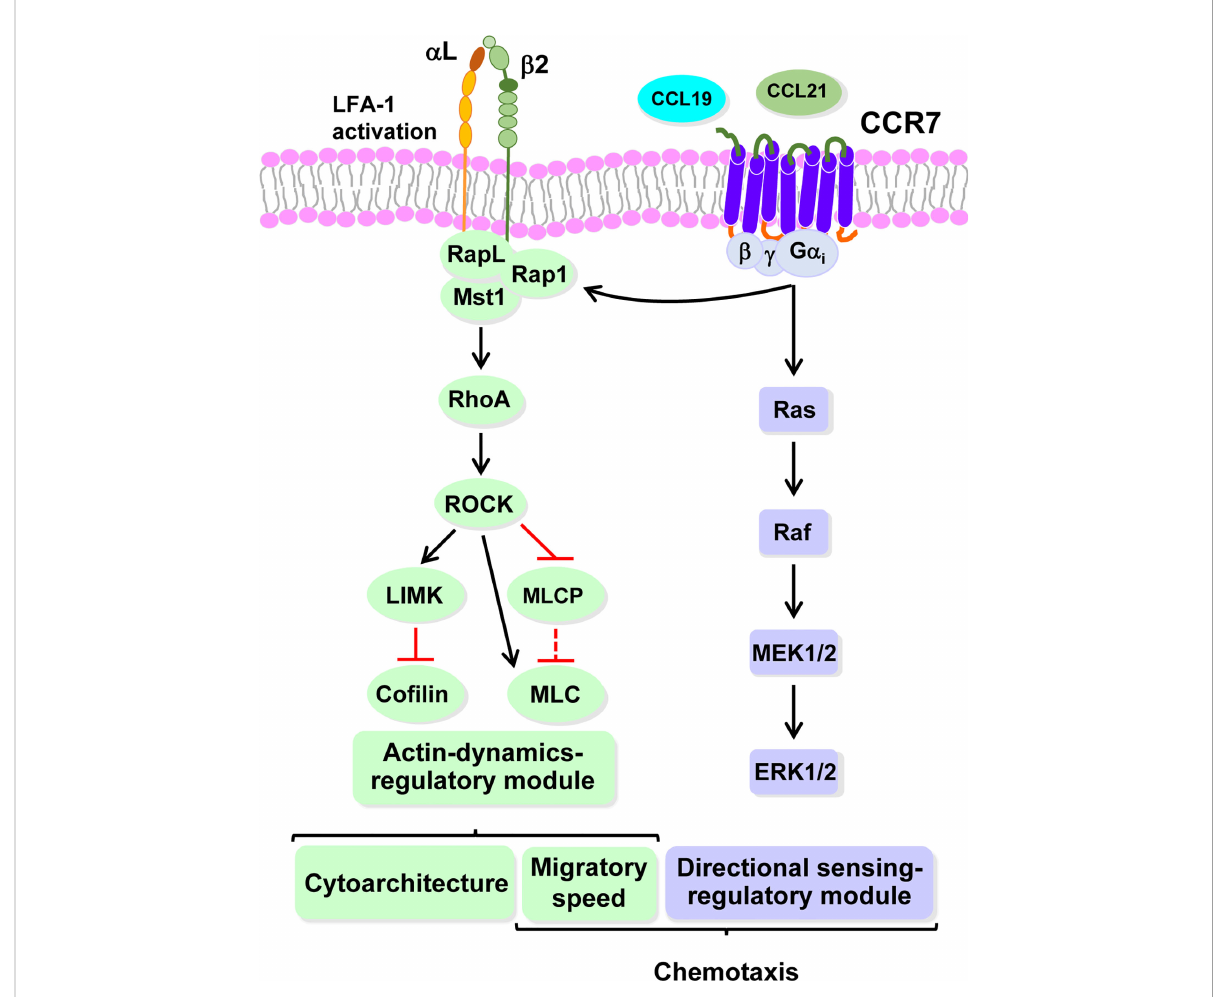
FIGURE 4 CCR7 could use highly independent signaling modules to regulate directional sensing and migratory speed in T cells. Hypothetical model based on recently published data (see text for details). The signalling module controlling CCR7-mediated actin dynamics that governs cytoarchitecture and migratory speed is downstream of RhoA, which is regulated by Mst1/RapL/Rap1 (green). RapL/Rap1 also govern LFA-1 integrin activation. Signaling module governing CCR7-mediated directional sensing (mallow). Abbreviations (see legends to Figure 1; Tables 2, 3, for additional abbreviations): LFA-1 ( a l b 2), Lymphocyte function-associated antigen-1; Rap 1, Ras-related protein 1; Rap L, Rap1-binding molecule, regulator of adhesion and cell polarization enriched in lymphoid tissues; Ras, Rat sarcoma viral oncogene